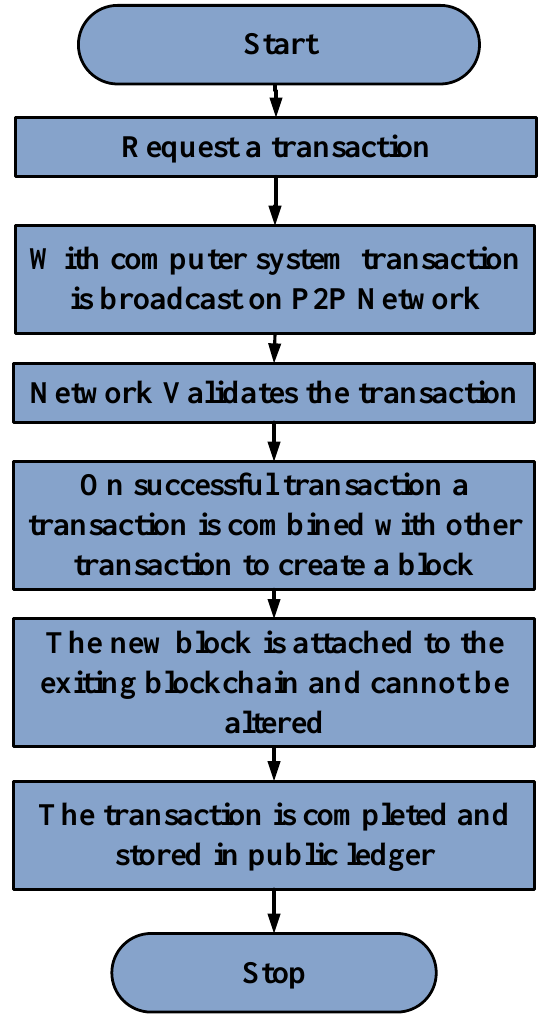
Figure 10. Working principle of blockchain